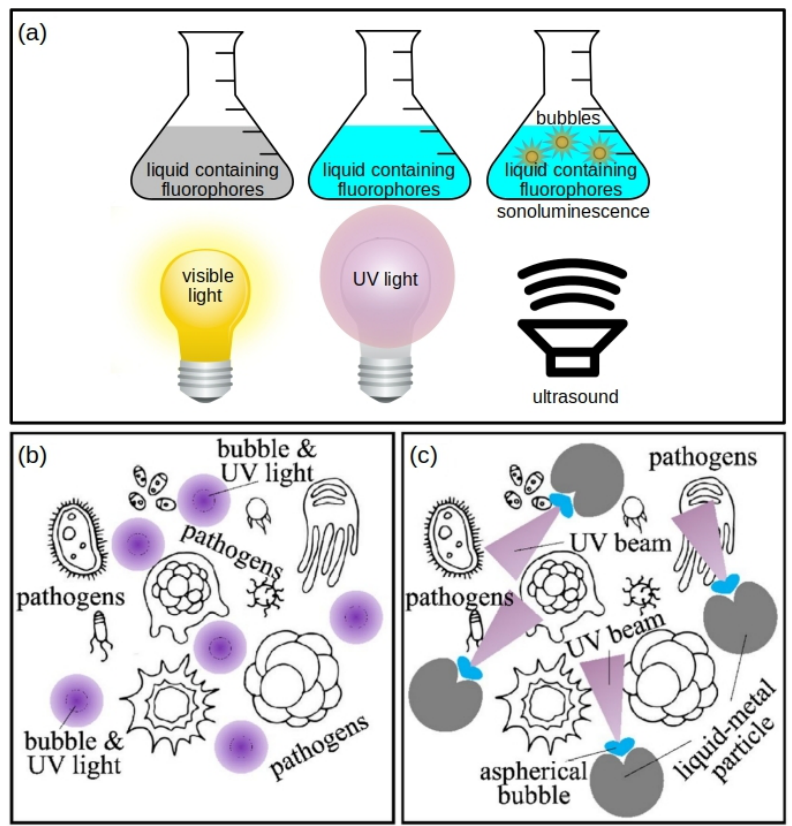
Figure 2. ( a ) Sketch of a potential proof-of-principle experiment involving a flask filled with water that contains a fluorescent material. When the flask is illuminated with visible light, the liquid does not change its colour. However, when the flask is illuminated with UV light, the liquid changes its colour due to fluorescence processes. In the rightmost image, the liquid in the flask contains bubbles, and it is irradiated with ultrasound, which leads to the emission of sonoluminescence light. Since the so-generated light has a significant UV component, fluorescence processes result in a change in the colour of the liquid. ( b , c ) The intensity of sonoluminescence light can be enhanced using plasmonic properties of metal nanoparticles that originate from the coupling of the light to a resonant oscillation of conduction electrons at the metal surface. This approach was theoretically demonstrated in [39] in the context of the disinfection of water contaminated by pathogens. Reproduced from [39] under